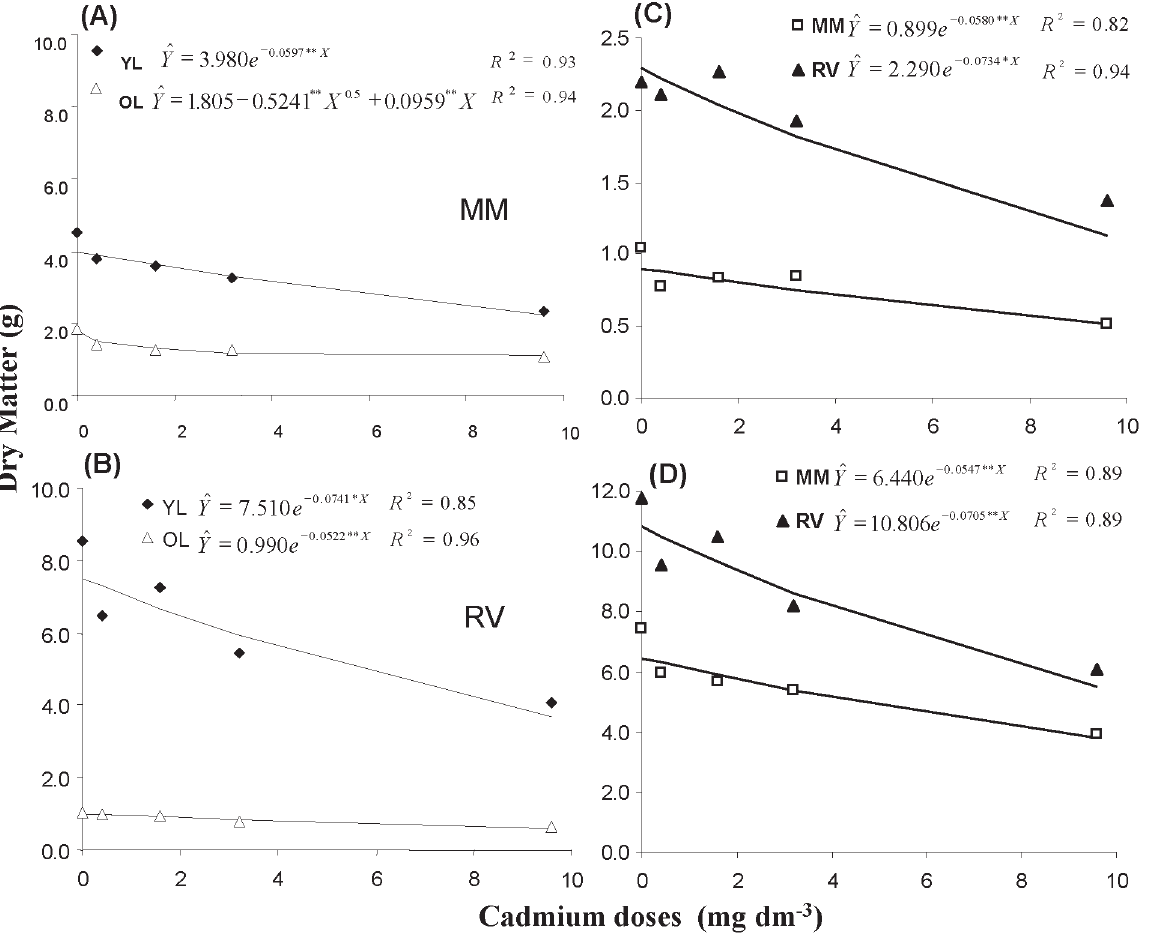
Figure 1 - Dry matter of: (A) young leaves-YL and old leaves-OL of Mimosa-MM; (B) young leaves-YL and old leaves-OL of Regina Verao-RV; (C) roots; and (D) whole plant, in lettuce cultivars Mimosa and Regina Verao, as a result of Cd doses applied to soil (plants were grown for 44 days in the Cd amended